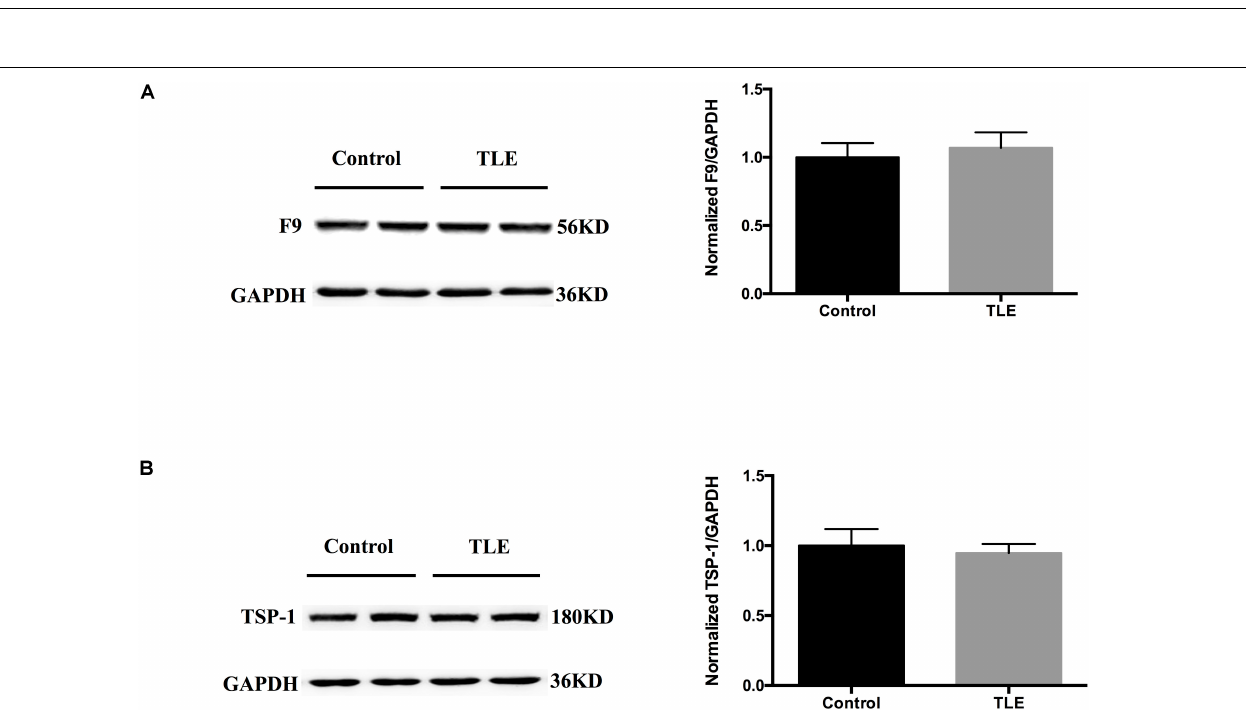
FIGURE 5 | F9 and TSP-1 were verified by ELISA in expanded sample sizes. ROC curves for exosomal proteins that are significantly different in epilepsy patients compared to healthy controls. (A) ELISA shows concentrations of F9 (a) and TSP-1 (b) in serum exosomes in different groups. Mann-Whitney U test was performed, n = 200 for each group, ∗∗∗∗ P < 0.0001. (B,C) ROC curves for exosomal F9 and TSP-1 were used to discriminate epilepsy patients and healthy controls, and the area under the ROC curve (AUC) was used to evaluate the level of discrimination.